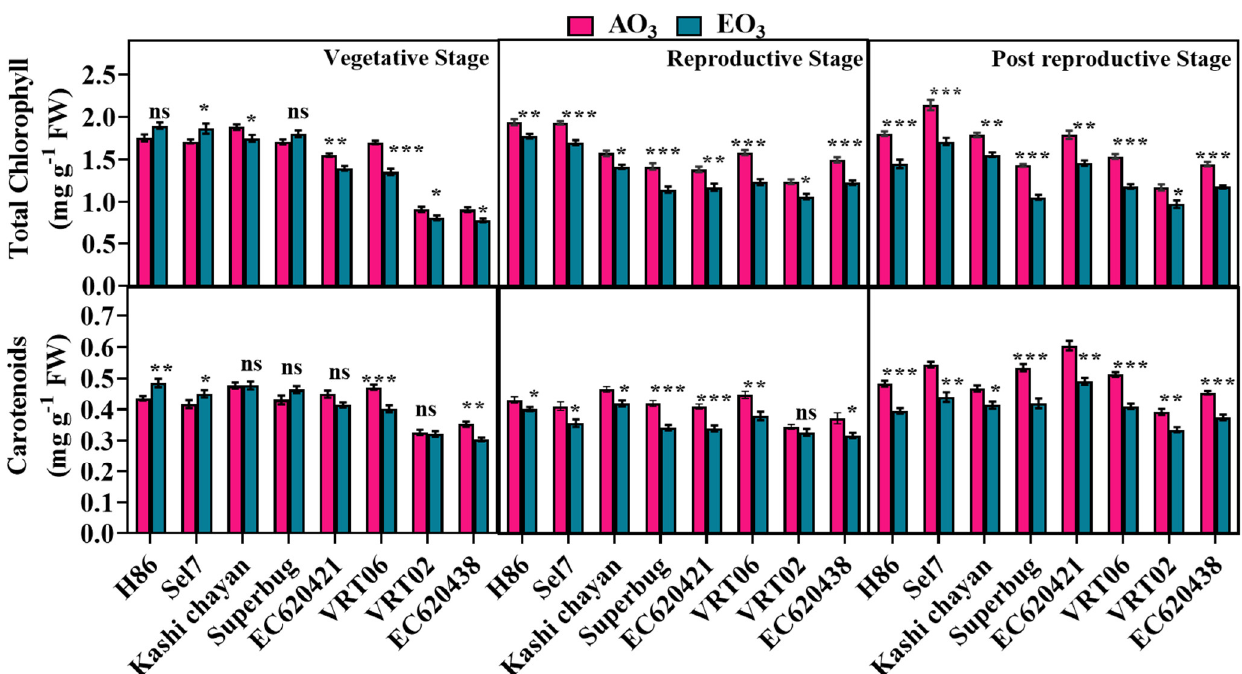
Figure 5. Total chlorophyll and carotenoid contents of tomato cultivars under AO 3 and EO 3 treat- ments at different growth stages. Values are mean ± SE. Level of significance between AO 3 and EO 3 based on t -test: * p ≤ 0.05; ** p ≤ 0.01; *** p ≤ 0.001; ns not significant.